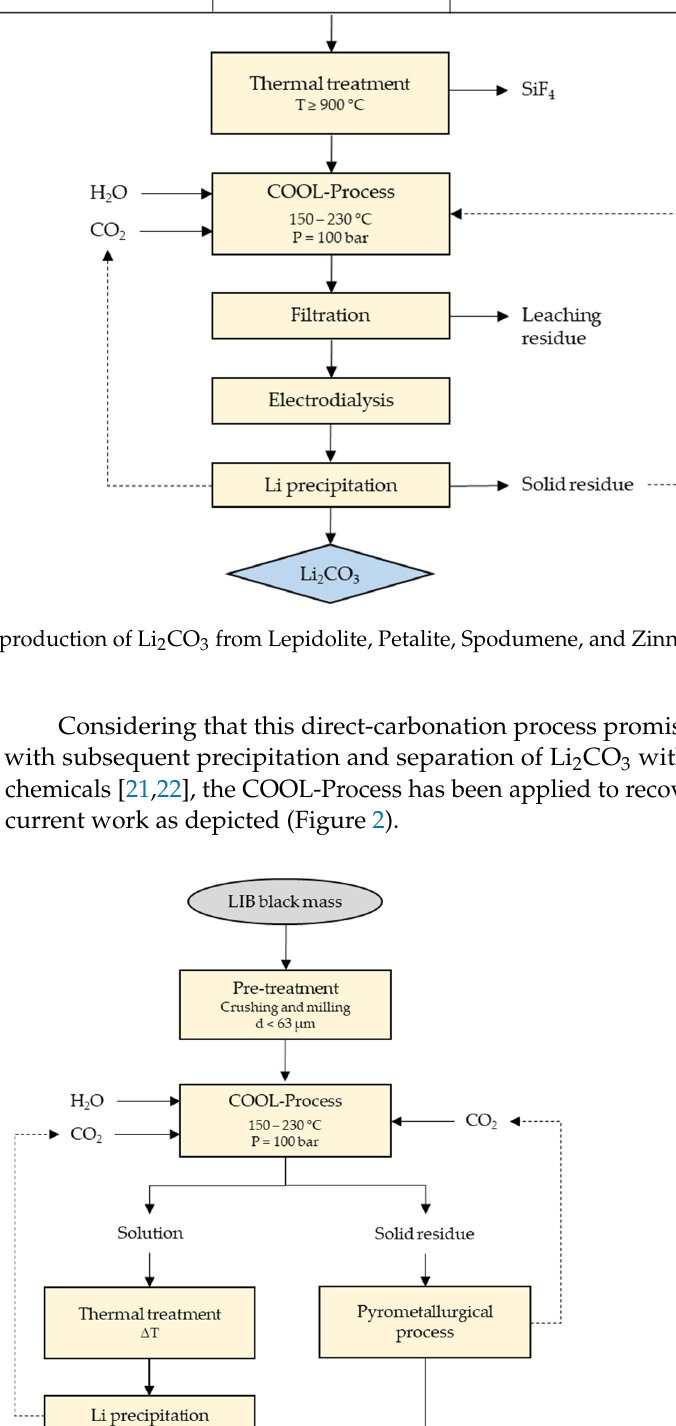
Figure 2. Recycling process scheme of lithium-ion batteries (LIB) black mass.